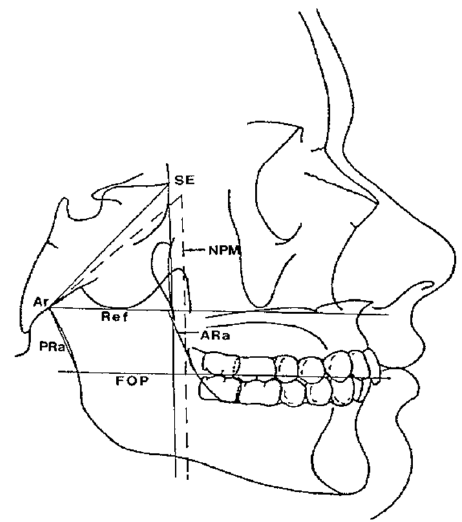
Figure 3. Ramus/MCF horizontal skeletal dimension.